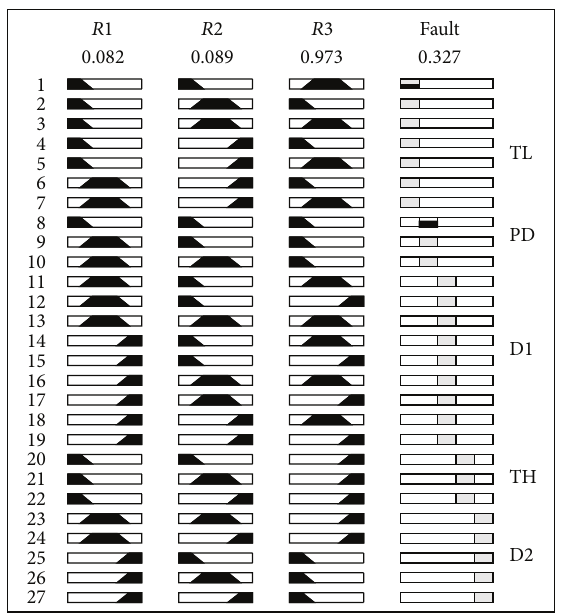
Figure 3: Rule viewer for case-I.